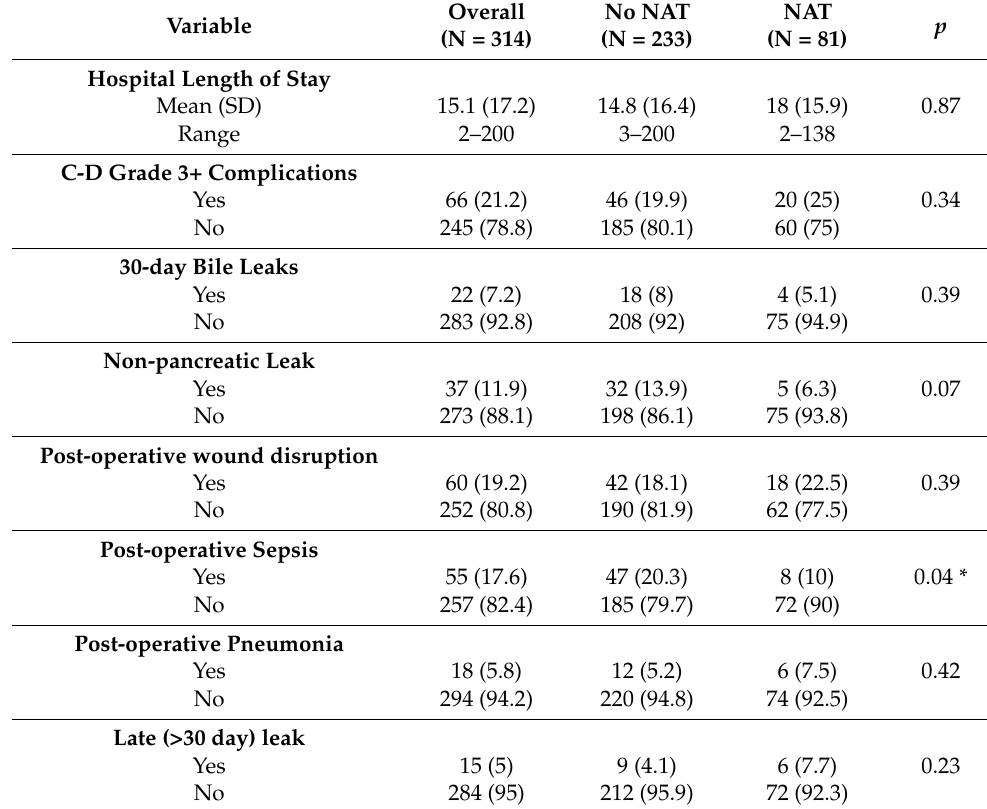
Table 3. Comparison of hospital LOS, early and late complications, and early and late readmission rates between patients who underwent NAT versus no NAT.